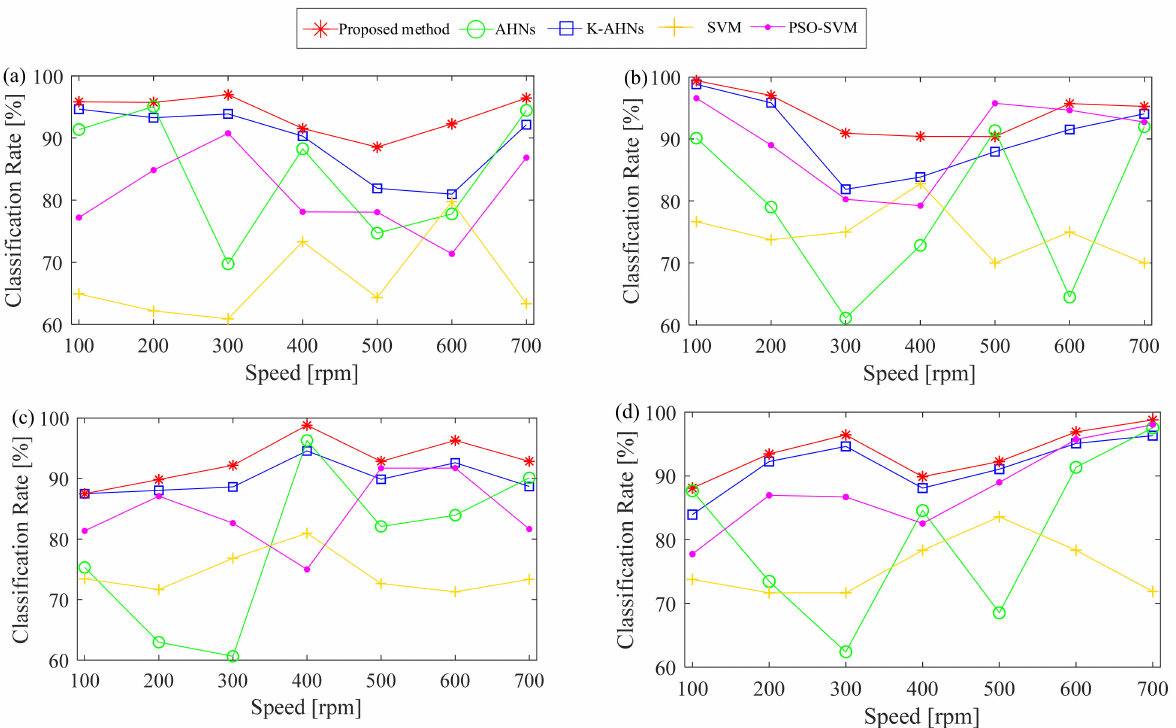
Figure 6. The classification results of five methods under different operating conditions. ( a ) No-load condition, ( b ) 10 N · m load condition, ( c ) 20 N · m load condition, ( d ) 30 N · m load